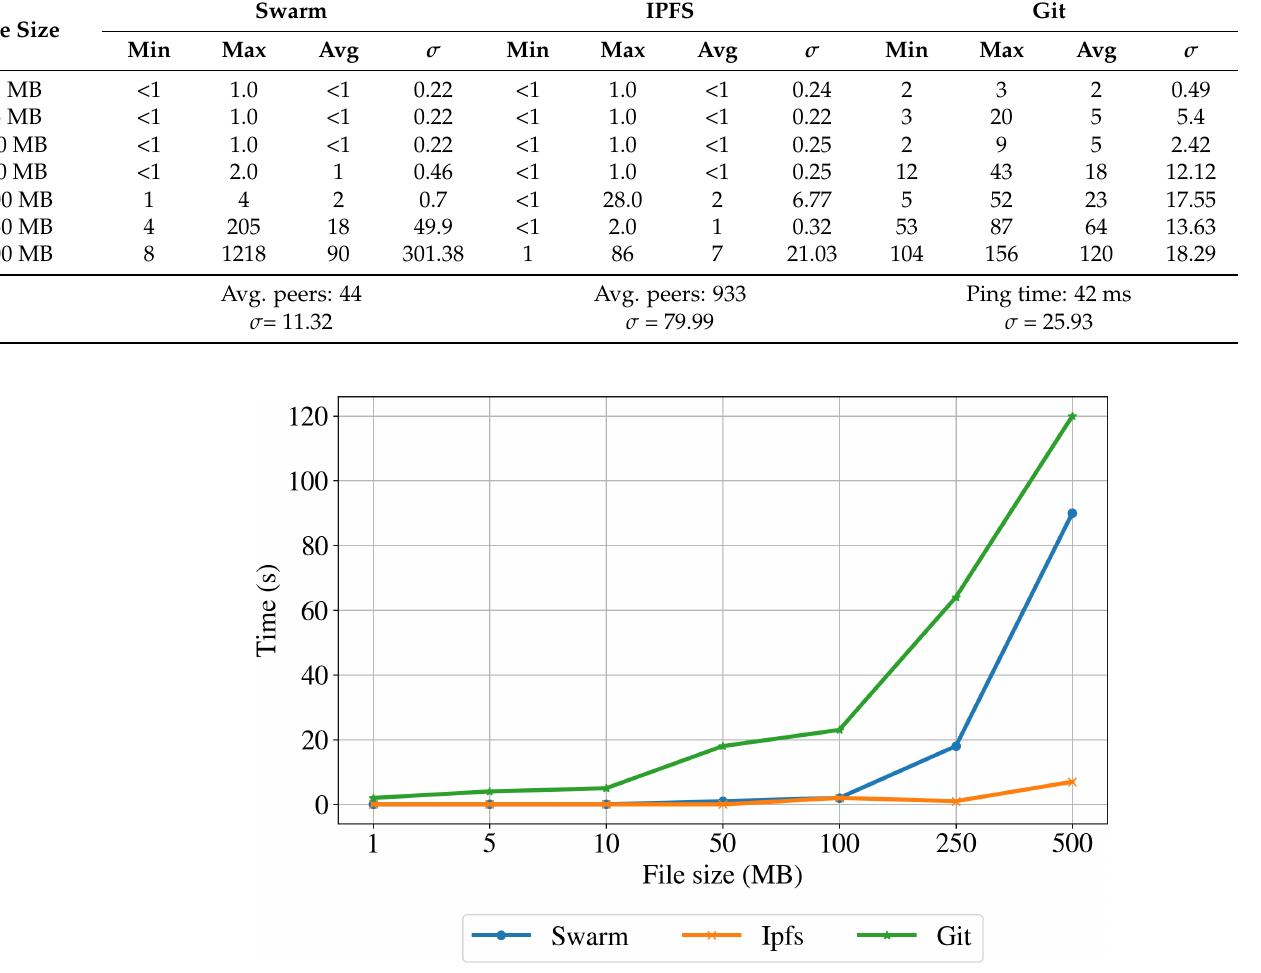
Figure 9. Average download times for different file sizes for the Swarm, IPFS, and Git